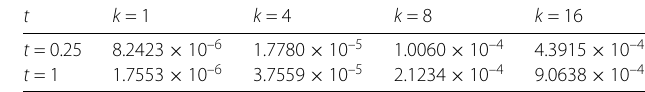
– I h u n (cid:7) 1, h with h = 1 h